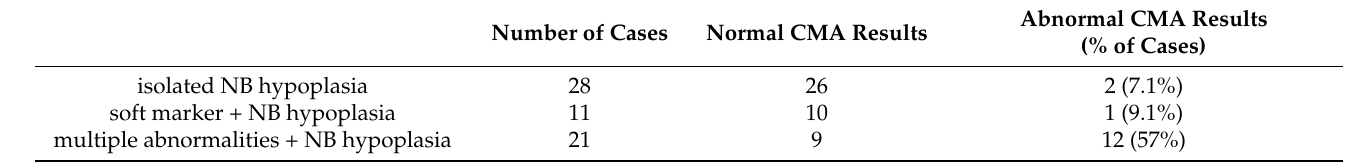
Table 4. Summary of the